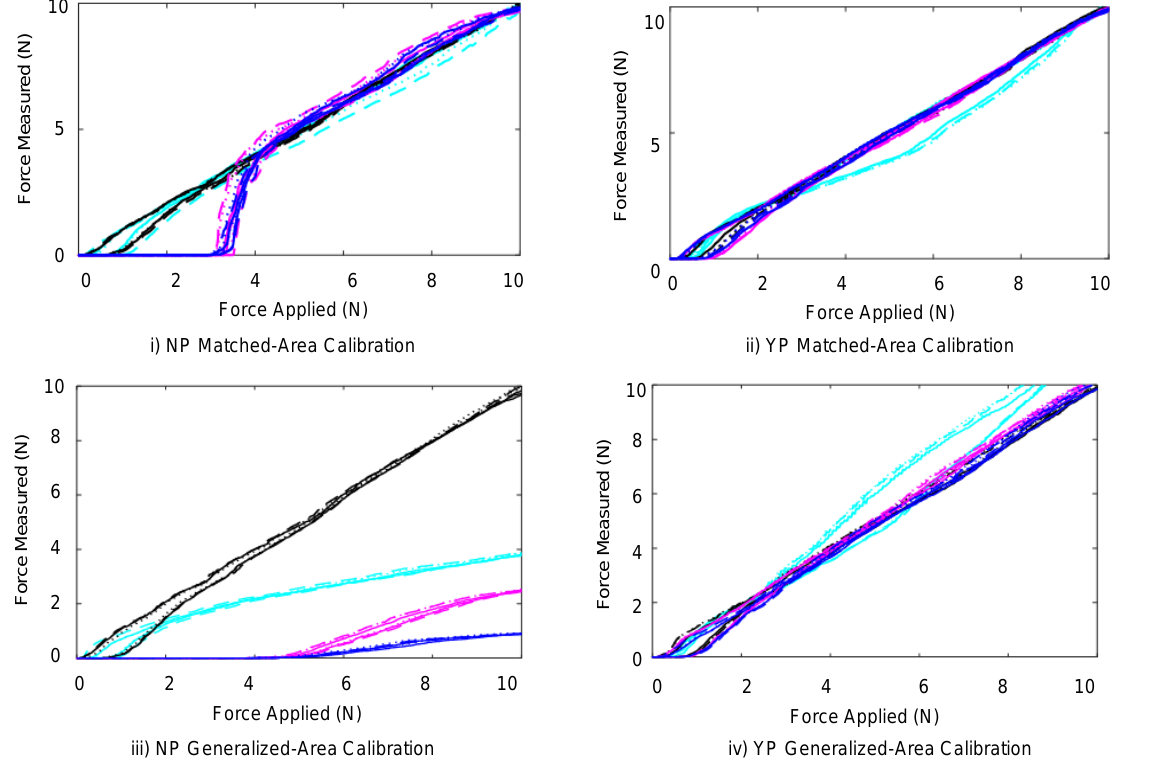
Figure 3: Force vs. time plots for two-second hysteresis tests for Sensitronic sensor using MA and GA calibration methods .